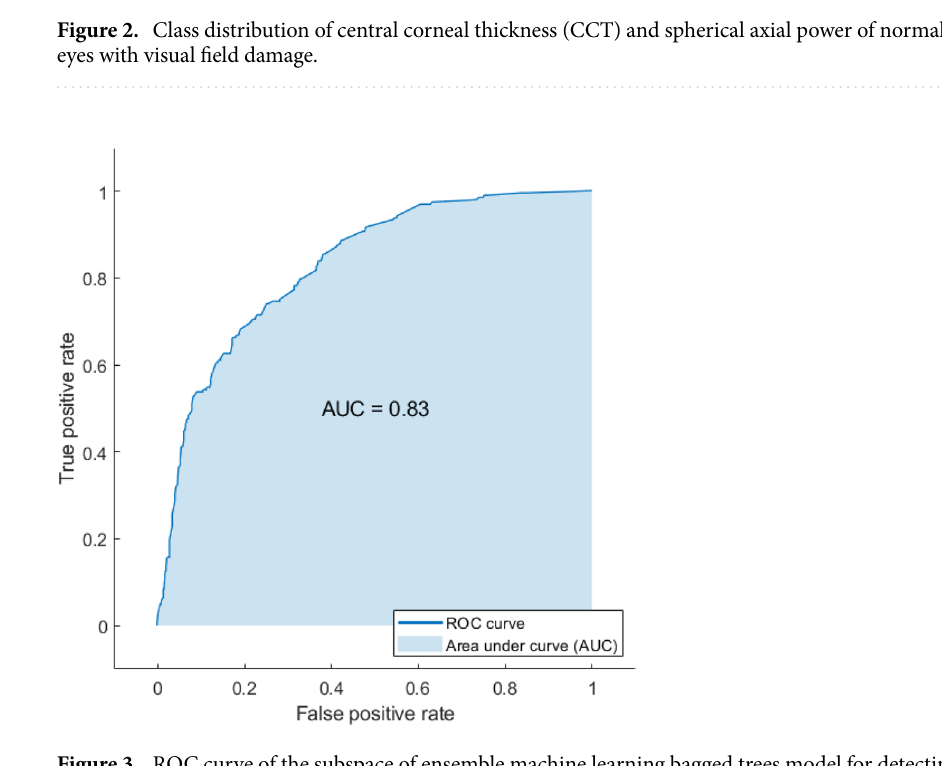
Figure 2 presents the distribution of the CCT versus spherical axial power in 3 mm zone of normal eyes and eyes with visual field damage. As can be seen, not all corneal parameters are discriminative for the eyes in these two groups. The ROC curve for detecting visual field damage from corneal parameters is shown in Fig. 3. The predicted visual field damage from corneal parameters versus the true visual field damage of eyes at different severity levels